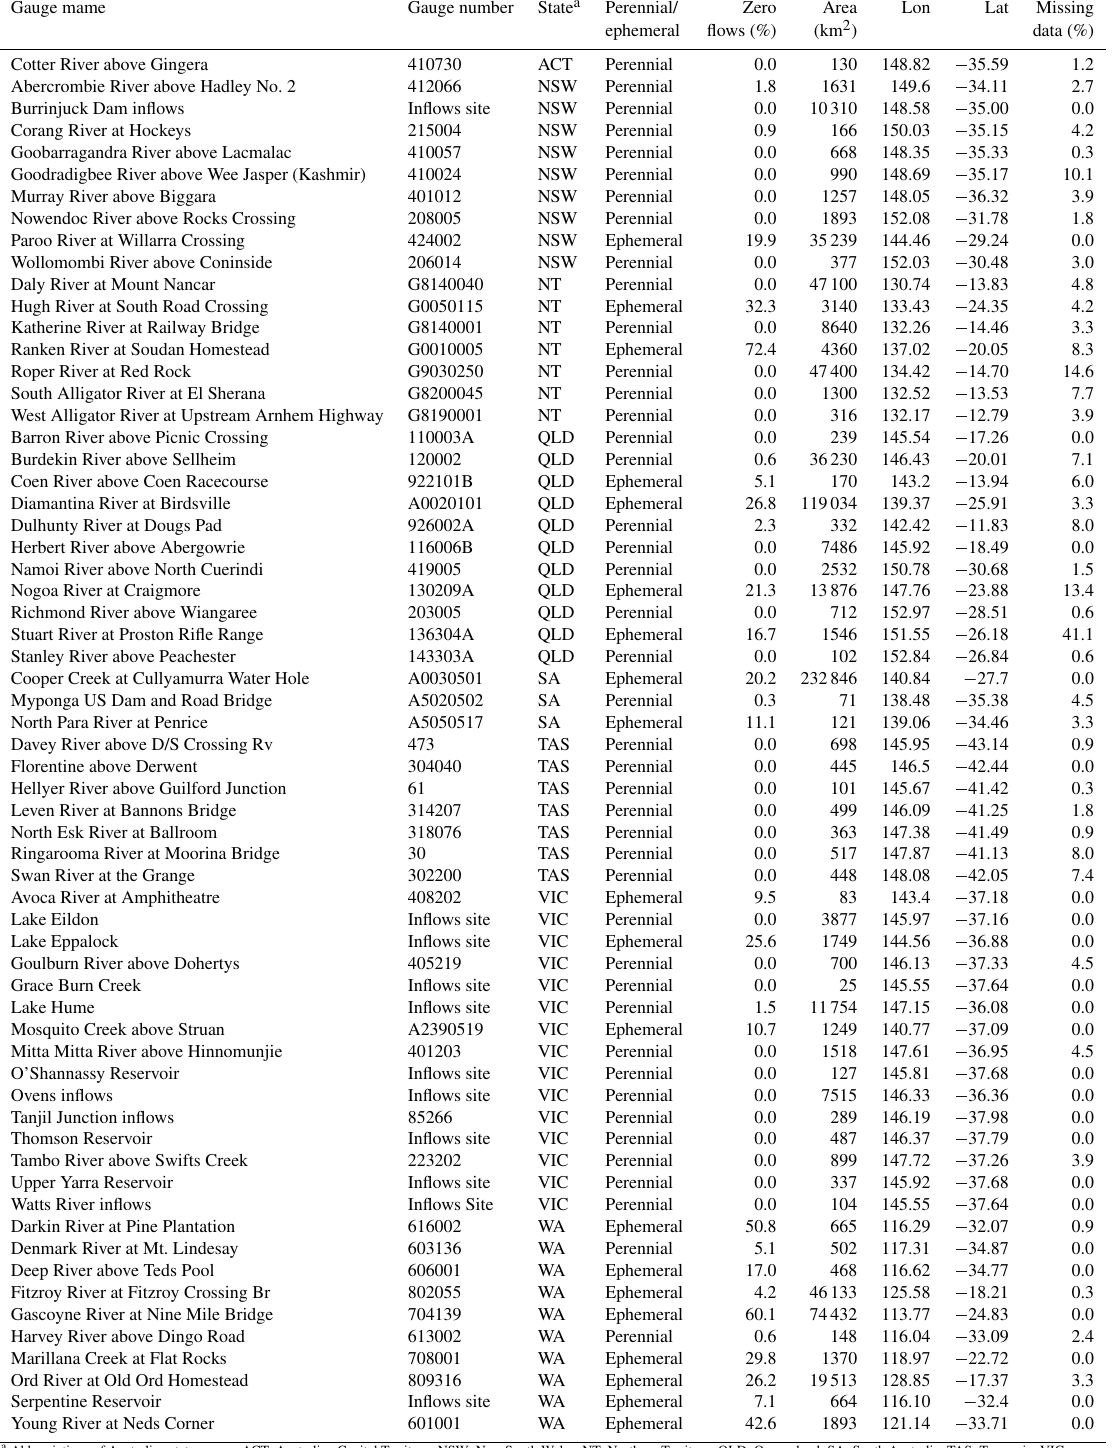
Table A1. List of